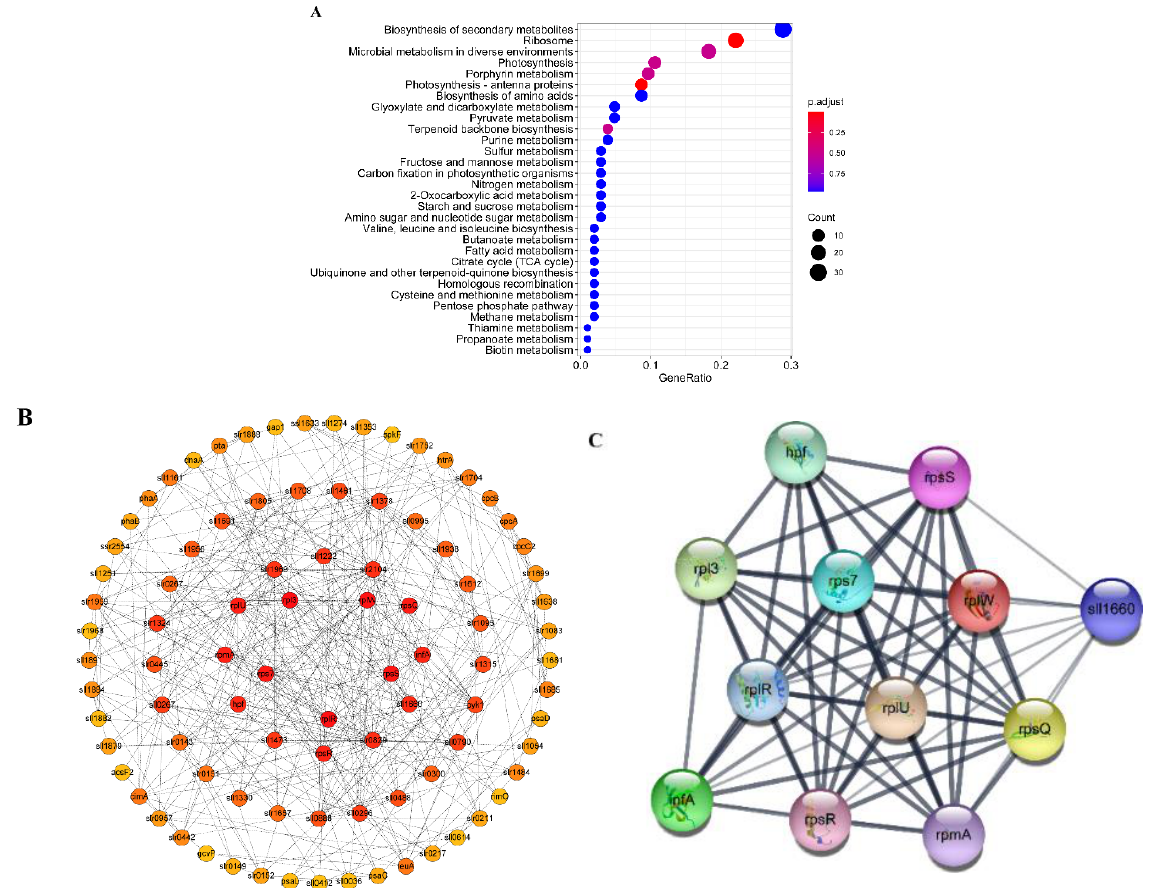
Figure 6. ( A ) Dot plots of DEPs enrichment analysis by KEGG. ( B ) The interaction network of the DEPs containing. ( C ) Top Protein – protein interaction networks in MCODE analysis.